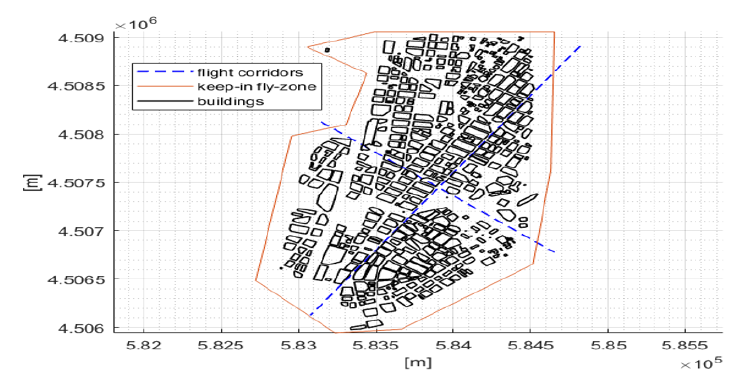
Figure 12. Example horizontal and vertical airway corridors in Manhattan.